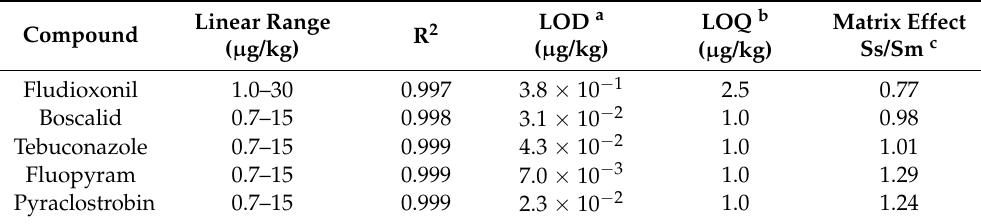
Table 3. Linear ranges, coefficients of determination (R 2 ), detection and quantification limits for the studied compounds and matrix effect.